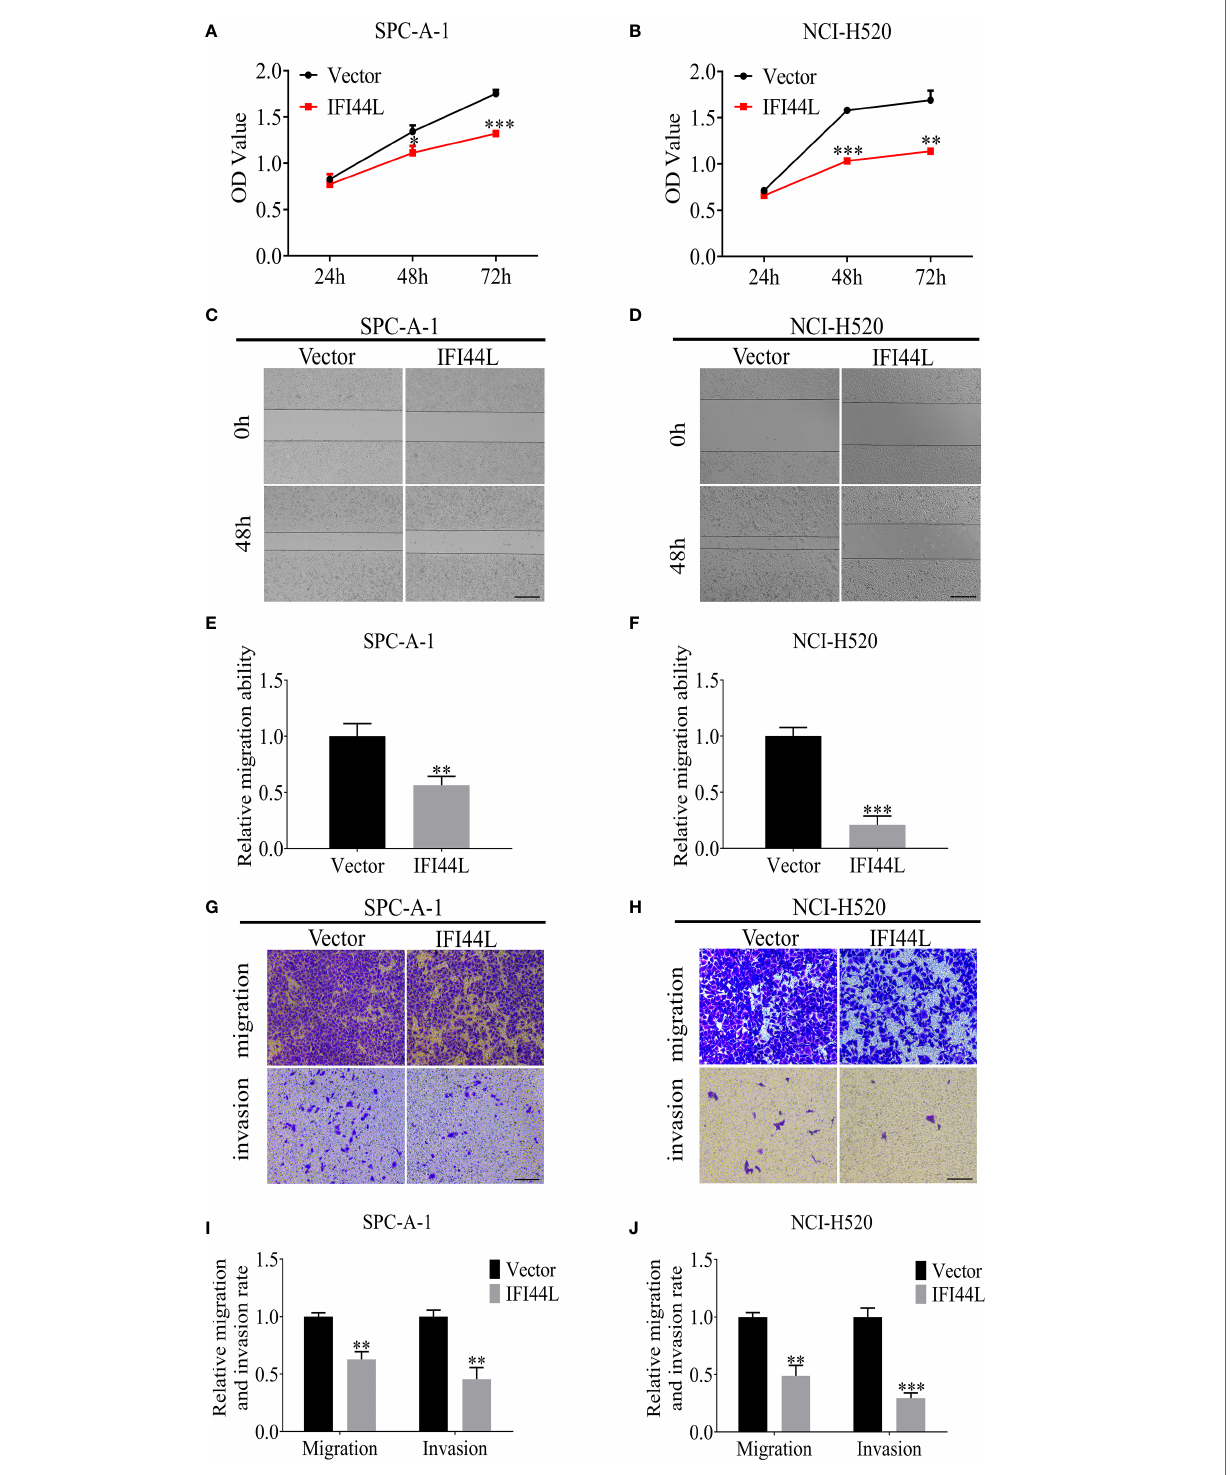
FIGURE 10 | Overexpression of IFI44L gene inhibited the proliferation, migration, and invasion of NSCLC cells. (A, B) CCK-8 assay was used to detect the effect of IFI44L overexpression on NSCLC cell growth. (C – F) The cell migration was detected after overexpression of IFI44L gene by scratch healing tests. Bar equals 100 µm. (G – J) Overexpression of IFI44L inhibited the migration and invasion of NSCLC cells by transwell assay. Bar equals 50 µm. NSCLC, non-small cell lung cancer; CCK-8: cell counting kit-8; * p < 0.05, ** p < 0.01, *** p <